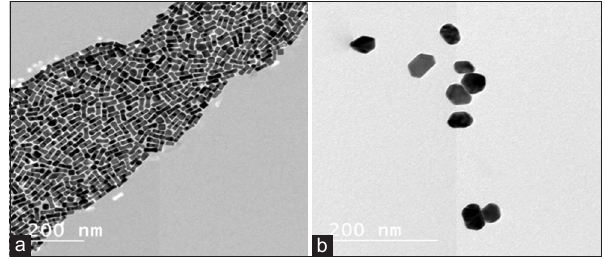
Figure-1: Photomicrograph using transmission electron microscopic showing 50 nm gold nanorods (a) and 50 nm gold nanosphere, (b) (bar=200